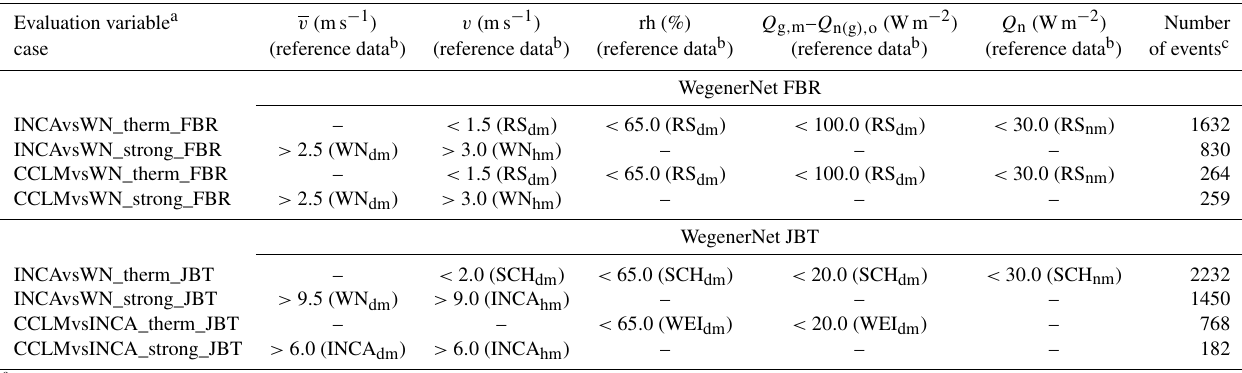
Table 2. Limits for the selection of thermally induced or strong wind events for the defined evaluation cases shown in Table 1 (top half for the WegenerNet FBR; bottom half for the WegenerNet